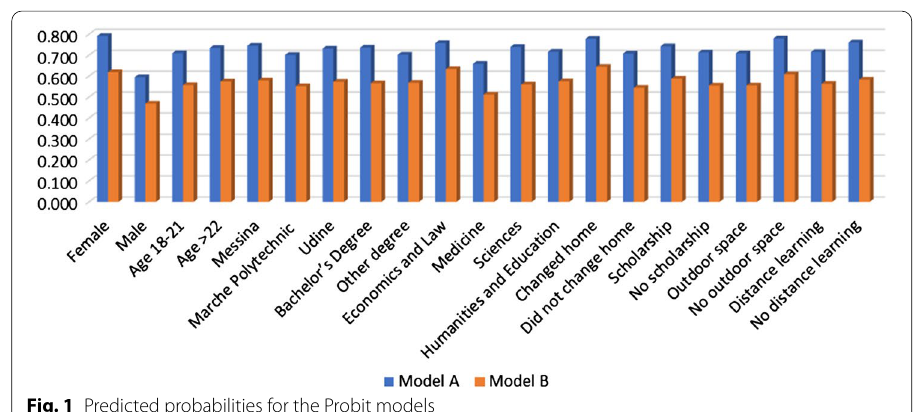
Fig. 1 Predicted probabilities for the Probit